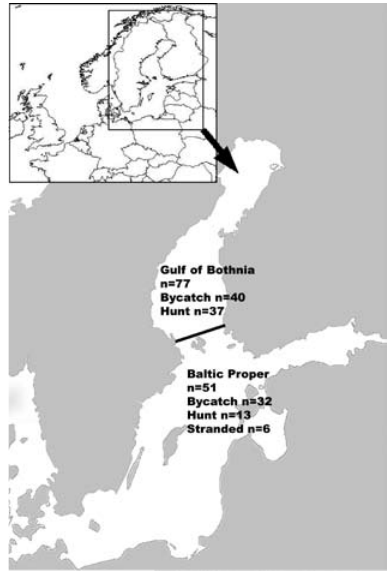
Fig. 2. Area of origin and cause of death of grey seals containing food remains, collected in the Baltic Sea